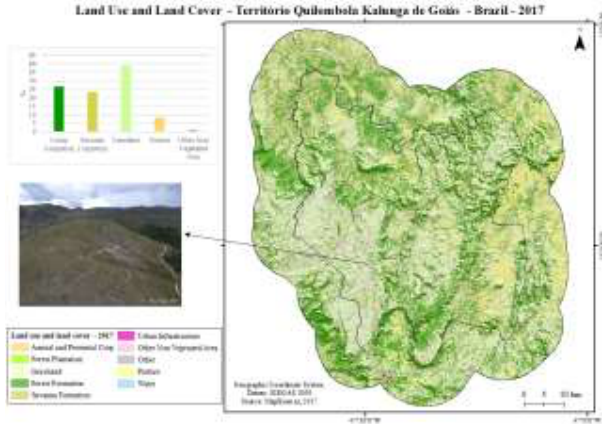
Figure 4. TKG land use and land cover and its surroundings. Figure A: ex. of grassland.